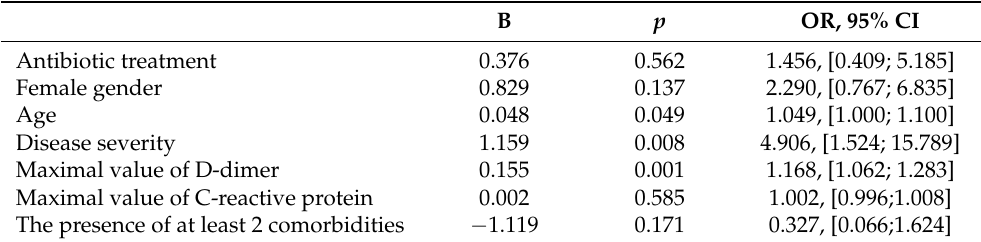
Table 6. Multivariate analysis concerning patients who received antibiotic therapy solely in an empirical manner—adjusted for age, gender, severity, inflammatory markers, and the presence of at least 2